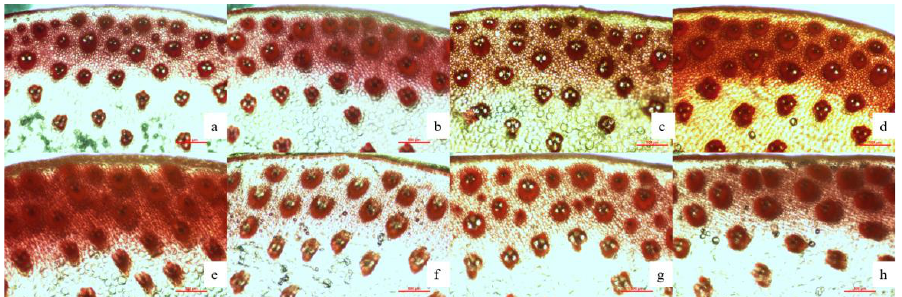
Figure 2. The Structure of the center vascular bundle of the 3rd basal internodes of maize treated with Se fertilizer. Note: ( a – d ) represent dongyang Se0,Se2,Se3 and Se4,respectively (×40); ( e – h ) represent shouyang Se0, Se2, Se3 and Se4,respectively ( × 40). Se0, Se fertilizer application 0 g ha − 1 ; Se2, Se fertilizer application 150 g ha − 1 ; Se3, Se fertilizer application 225 g ha − 1 ; Se4, Se fertilizer application 300 g ha − 1 . Different lowercase letters in the same column indicate significant differences among different treatments ( p <